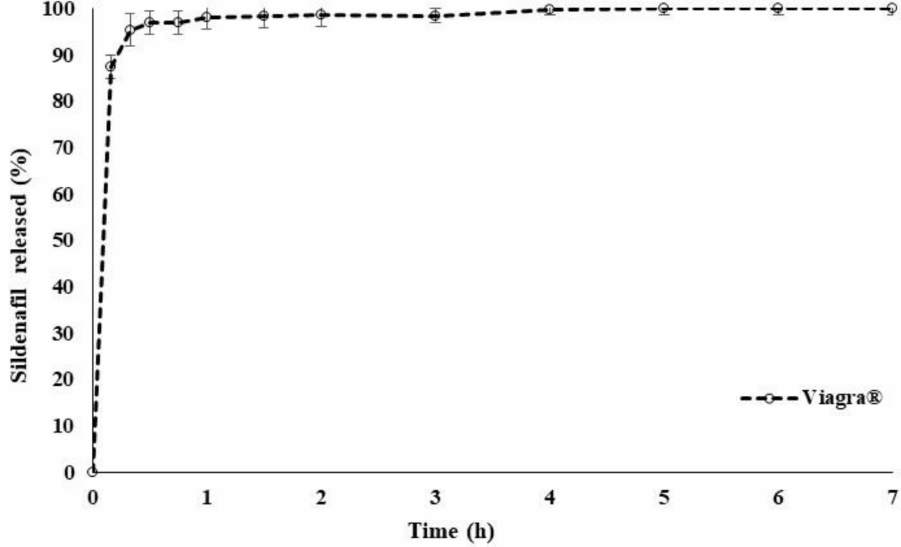
Figure 1. SDF release profile from branded drug Viagra ® 50 mg in distilled water at 37 ◦ C ( n =